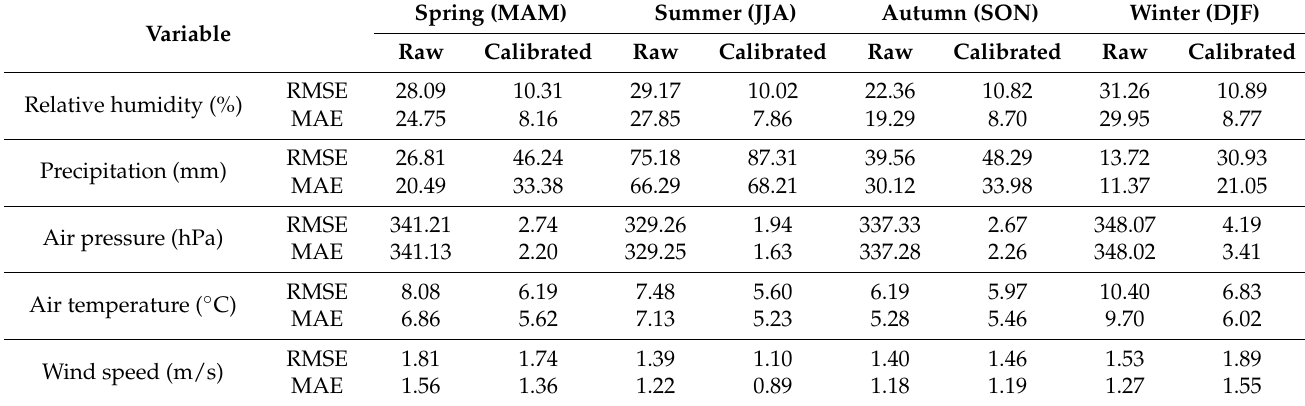
Table 3. Performance of this adjustment approach averaged over the 36 QTP sites stratified by seasons in terms of RMSE and MAE values before (raw) and after (calibrated) the first adjustment based on the GCM EC data. The metrics are measured against the site observations. N = 45 on each site for each